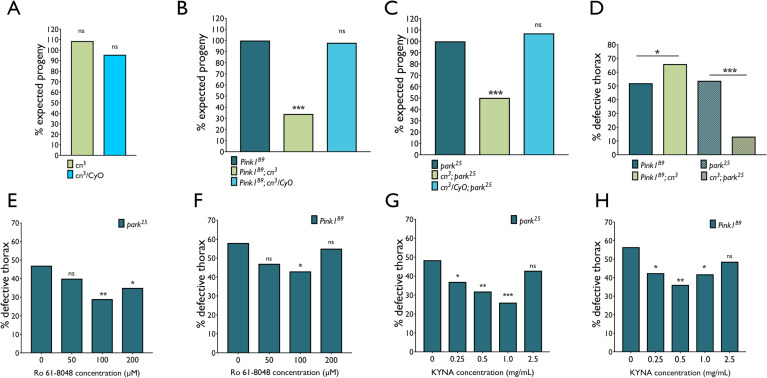
Homozygous cn LOF causes synthetic lethality in Pink1B9 and park25 flies.(A)
cn3/CyO in a w- wild-type background were self-crossed. The expected Mendelian ratio of cn3 to cn3/CyO flies is 1:2. CyO is homozygous lethal. % expected progeny was calculated from the total number of progeny. (B) Crosses were set up to generate Pink1B9 flies carrying the cn3 allele. The ratio of Pink1B9 to FM6 flies is 1:1. % expected progeny was calculated as the proportion of Pink1B9 male progeny in relation to FM6 (χ2 test, 1 d.f., *** P < 0.001). (C) Expected progeny was calculated in proportion to the number of corresponding park25/TM6B flies that eclosed (χ2 test, 1 d.f., *** P < 0.001). (D) Penetrance male defective thorax phenotype of Day 1 Pink1B9 or park25 males combined with homozygous cn3. Penetrance in the Pink1B9; cn3 and cn3; park25 genotypes was compared to the park25
stock. χ
2
test, 1 d.f., * P < 0.0125, *** P < 0.00025. (E) Effect of KMO inhibitor Ro 61–8048 on defective thorax phenotype in park25 and Pink1B9
(F) flies (χ
2
test, 1 d.f., * P < 0.0167, *** P < 0.0003) (G) Effect of KYNA supplementation on defective thorax phenotype in park25 and Pink1B9
(H) flies.